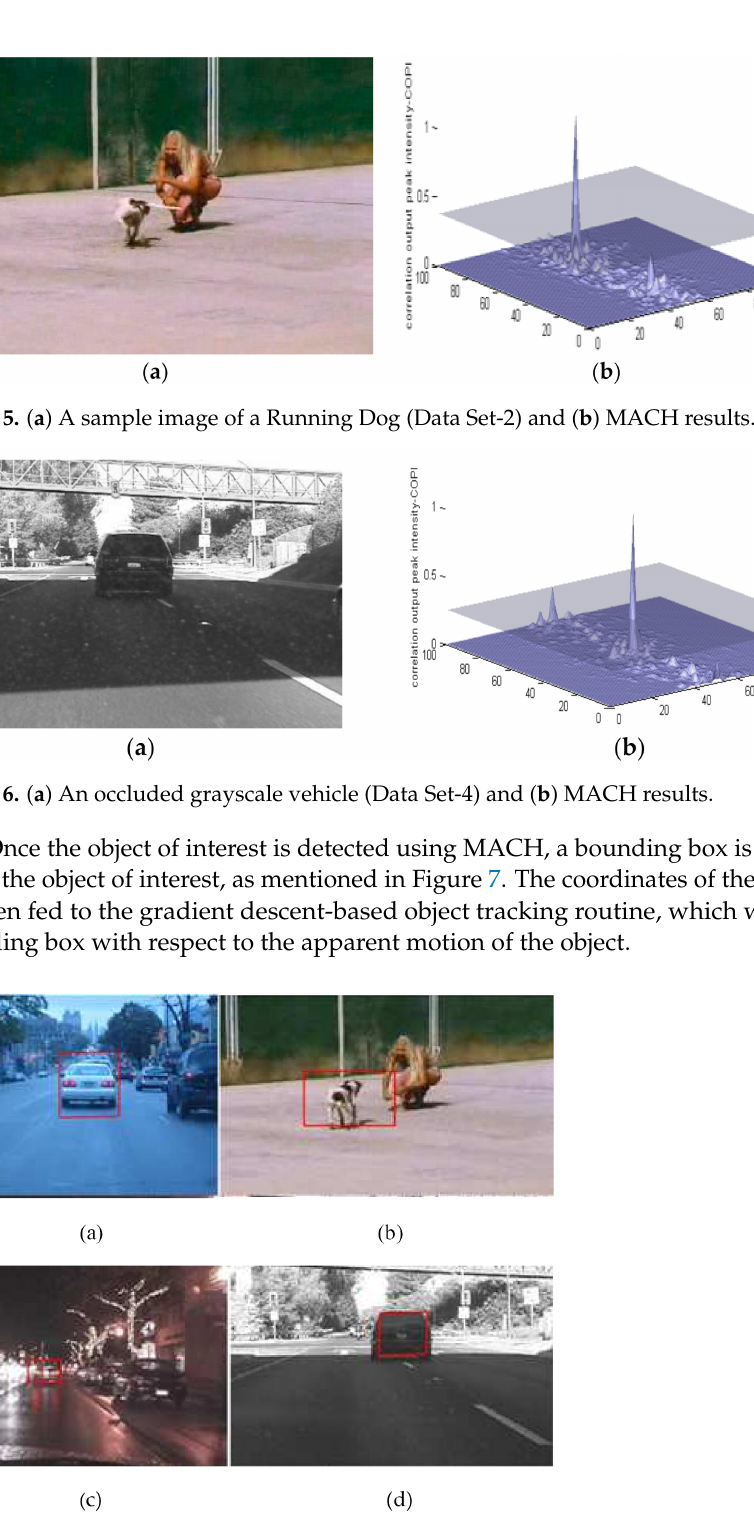
Figure 7. Detected objects for sample images: ( a ) Blurred Vehicle; ( b ) Running Dog; ( c ) Vehicle at Night; ( d ) Car moving in a